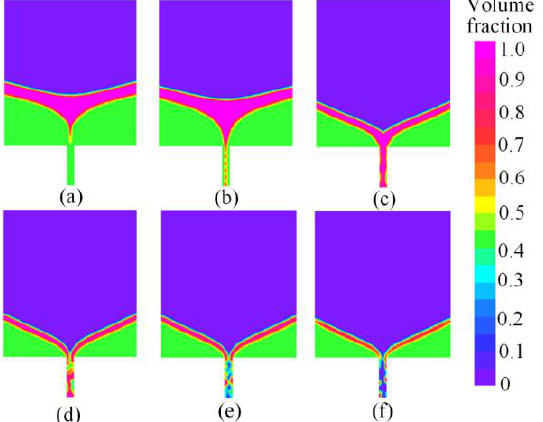
Figure 2. Volume fraction cloud profiles of the multiphase vortex. ( a ) t = 15.0 s, ( b ) t = 18.5 s, ( c ) t = 38.0 s, ( d ) t = 43.5 s, ( e ) t = 46.50 s, ( f ) t = 53.0 s. ( c ) t = 38.0 s, ( d ) t = 43.5 s, ( e ) t = 46.50 s, ( f ) t = 53.0